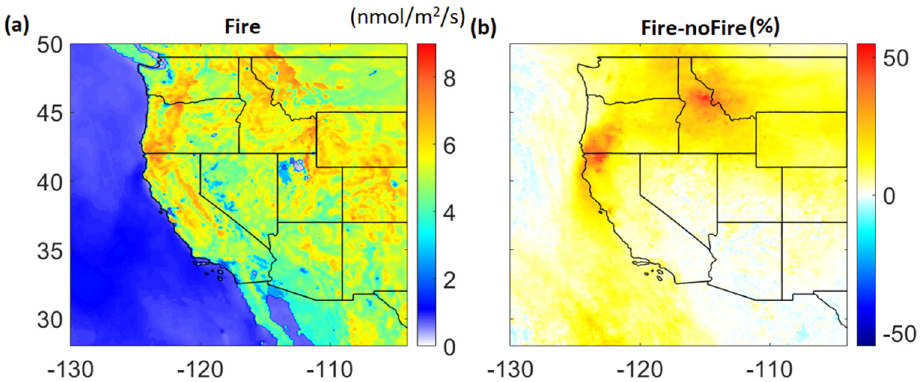
Figure 18. Spatial distribution of average ( a ) surface ozone dry deposition flux in nmol/m 2 /s from the ‘Fire’ simulation and ( b ) percentage difference in surface ozone dry deposition flux between the ‘Fire’ and ‘noFire’ simulations relative to the ‘noFire’ simulation for the first half of September 2017.